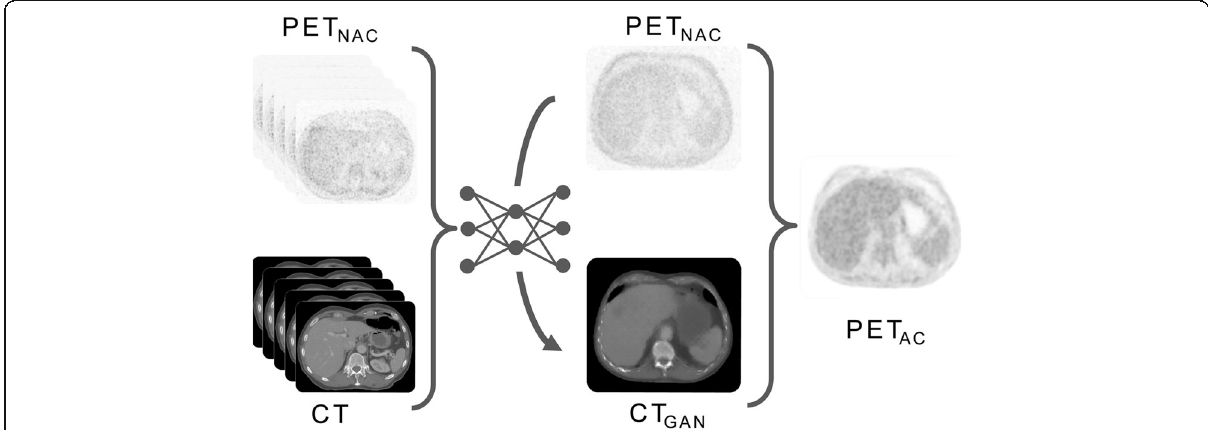
Fig. 1 Process of independent whole body PET AC. Paired training data of non-attenuation corrected PET (PET NAC ) and corresponding acquired CT are used to train a deep neural network to generate pseudo CT (CT GAN ) from PET NAC . This pseudo CT can then be used for PET attenuation- correction resulting in an attenuation corrected PET data set (PET AC